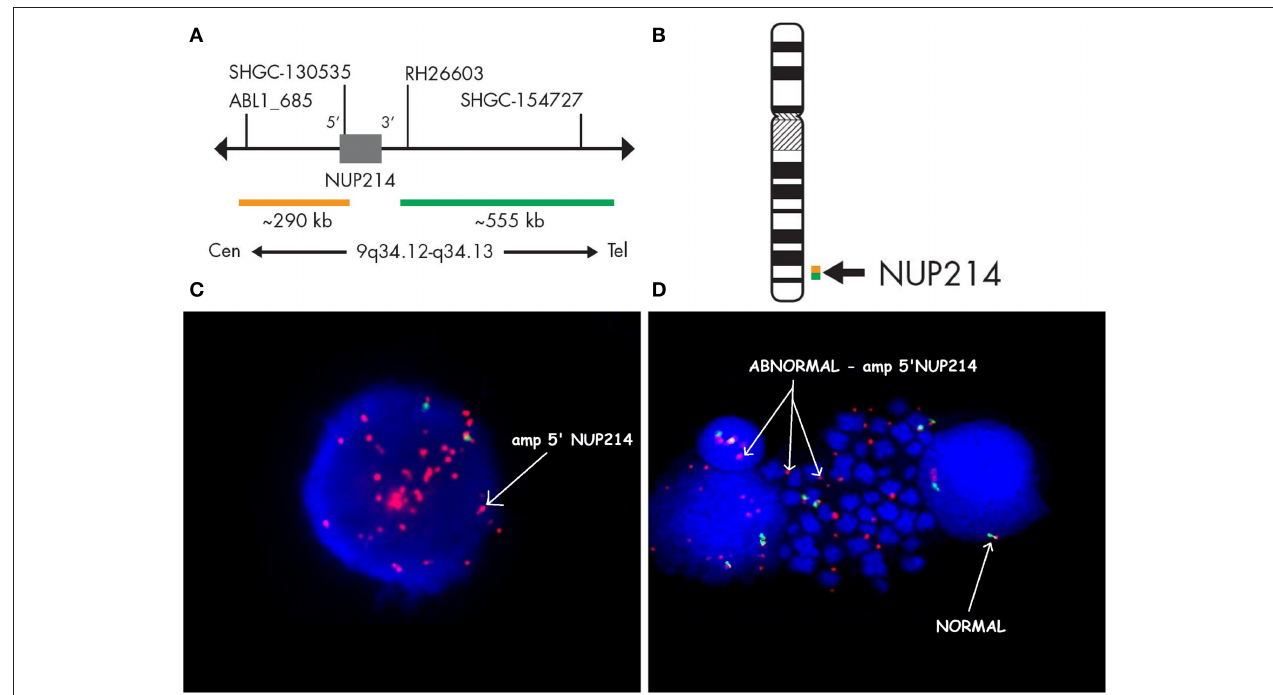
FIGURE 4 | Fluorescence in situ hybridization revealing an amplification of NUP214. SPEC NUP214 probe map (A) . Ideogram of chromosome 9 indicating the hybridization locus (B) . Images of the FISH results with the ZytoLight-SPEC NUP214 Dual Color Break Apart Probe revealing NUP214 amplification (C,D) . FISH was performed on both interphase (C) and metaphase cells (D) . Cells displaying NUP214-ABL1 amplification are shown (arrows). Normal cells exhibited two red/green signals (arrows). Episomes are represented as small dots between chromosomes (D)